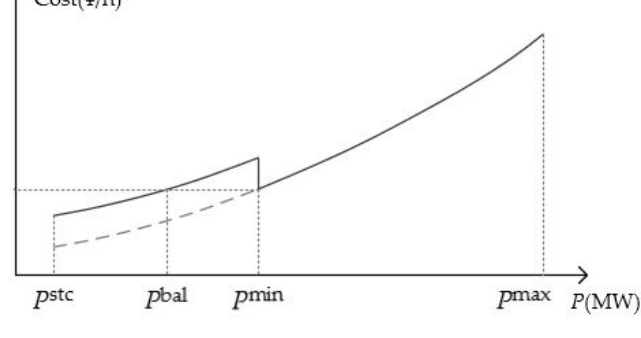
Figure 1. Fuel cost curve for LLOAF.